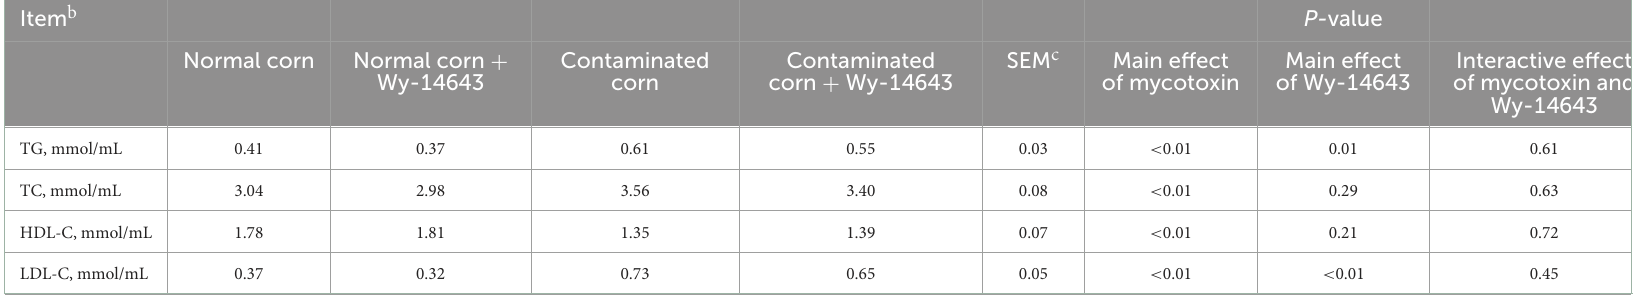
TABLE 6 Effects of PPAR- α agonist on serum lipid in broilers fed mycotoxin contaminated corn a .